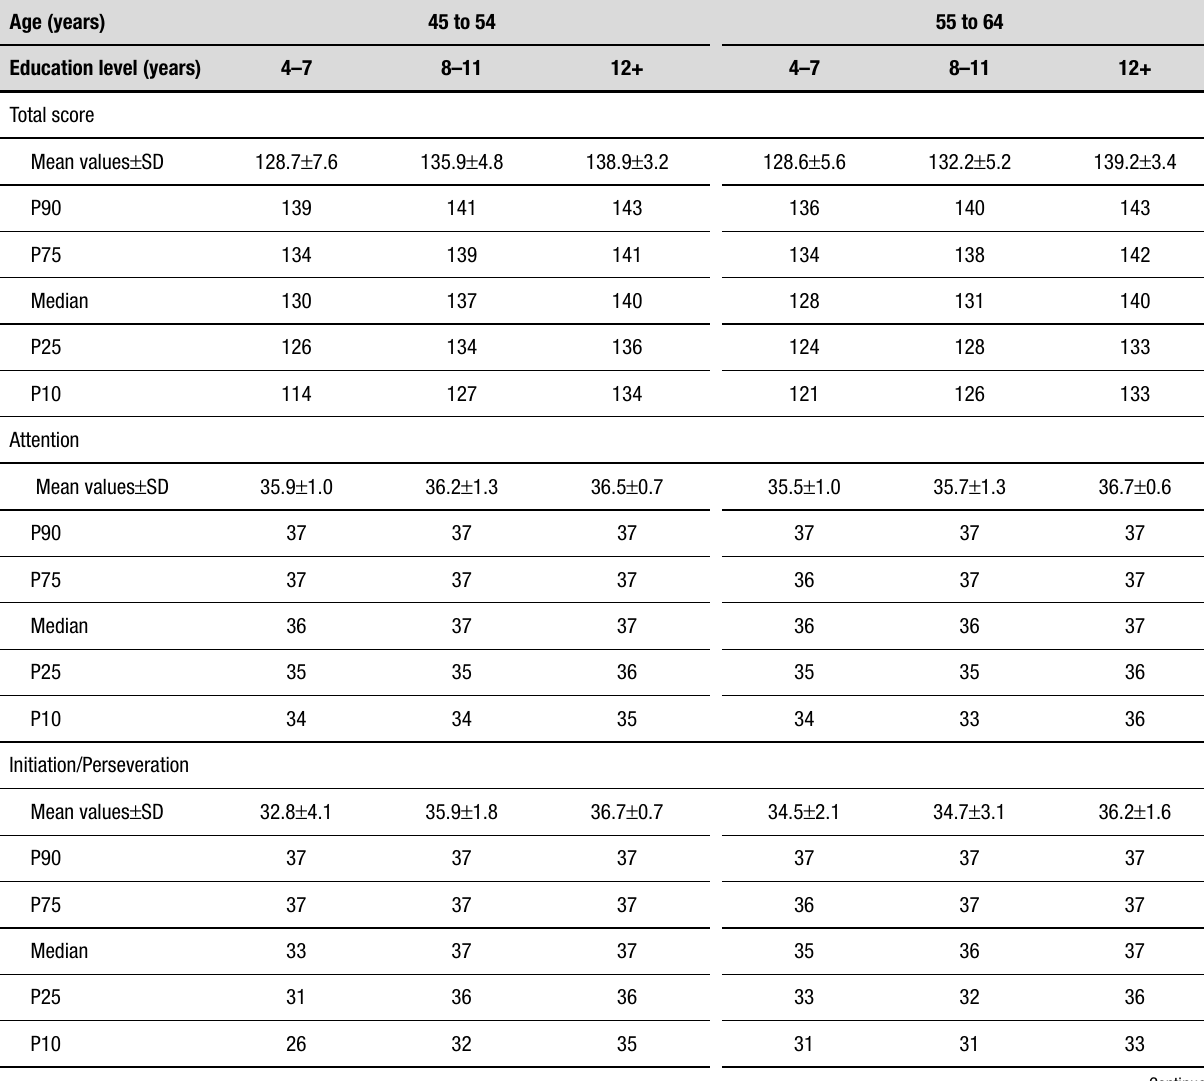
Table 3. Normative data in the Mattis Dementia Rating